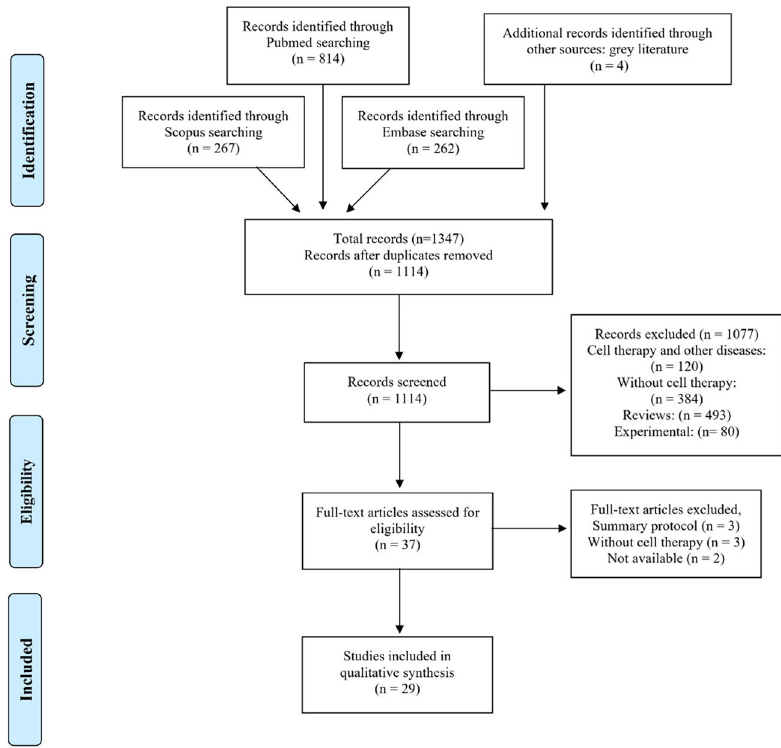
Fig. 1 PRISMA fl ow diagram. Summary of evidence search and study